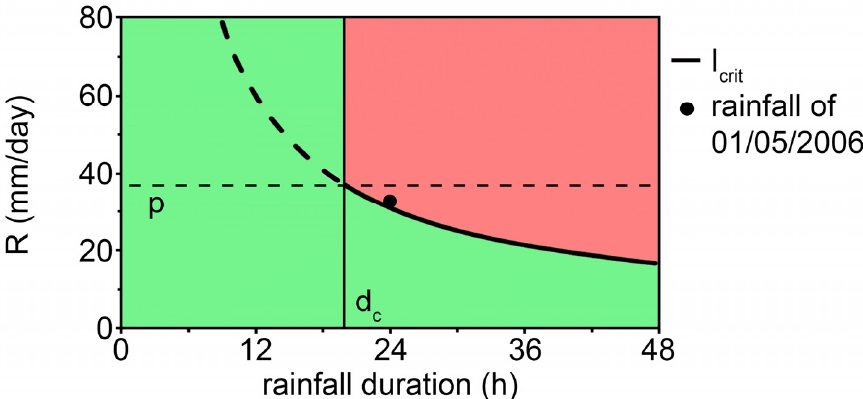
Figure 9. Comparison between the rainfall event recorded on 5 October 2005 and the critical curve calculated at the depth of 0.80 m.